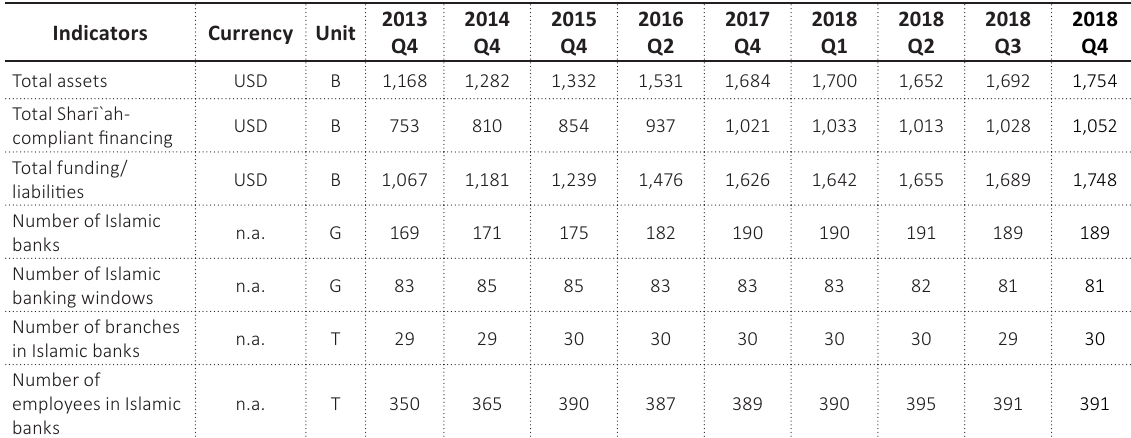
Table 1. Selected aggregated Islamic financial indicators based on the Islamic Finance Service Board (IFSB)